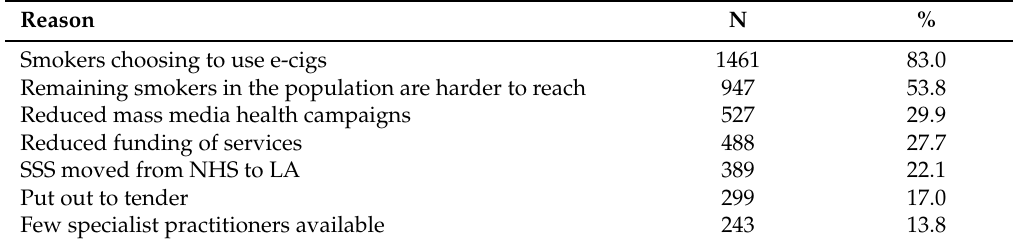
Table 5. Reasons for the decline in SSS client